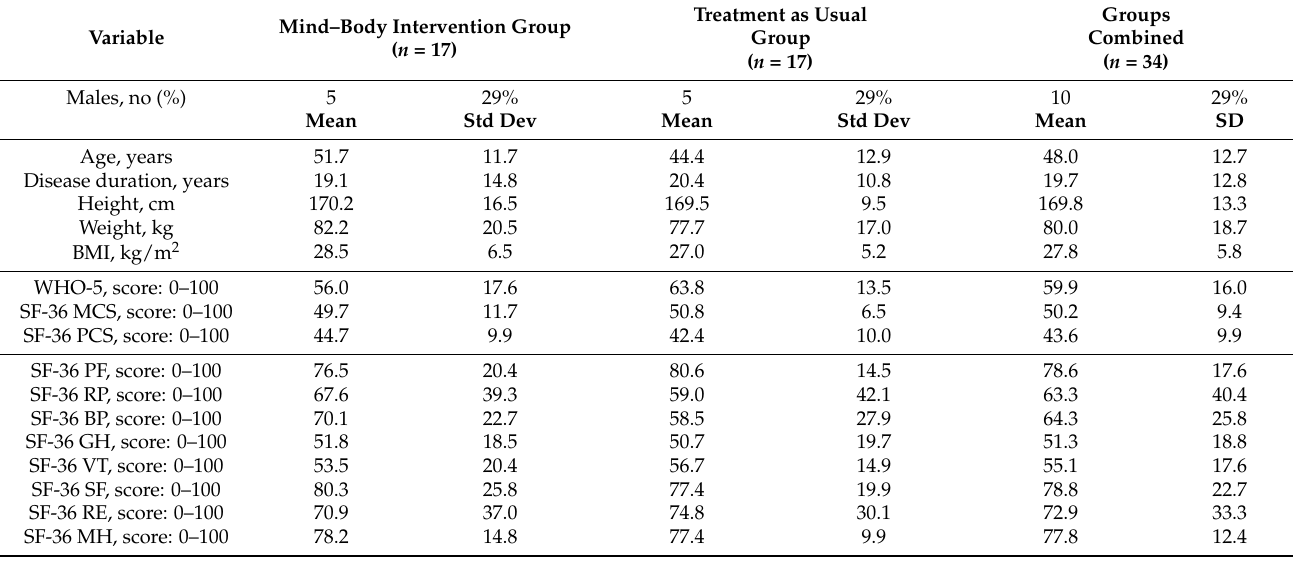
Table 1. Baseline Characteristics and Values for Primary and Secondary Outcomes in the Combined ITT population. Mind–Body Intervention Group Variable ( n = 17)